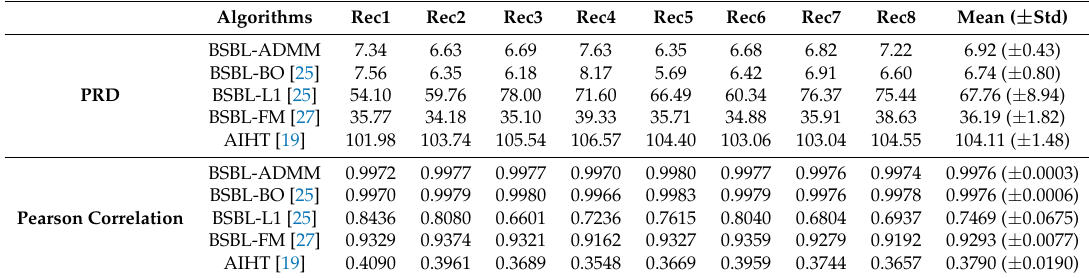
Table 1. The details of recovery accuracy of practical wearable ECG datasets (CR = 60%). These results show that the proposed BSBL-ADMM algorithm is robust for the recovery accuracy for different ECG recordings.